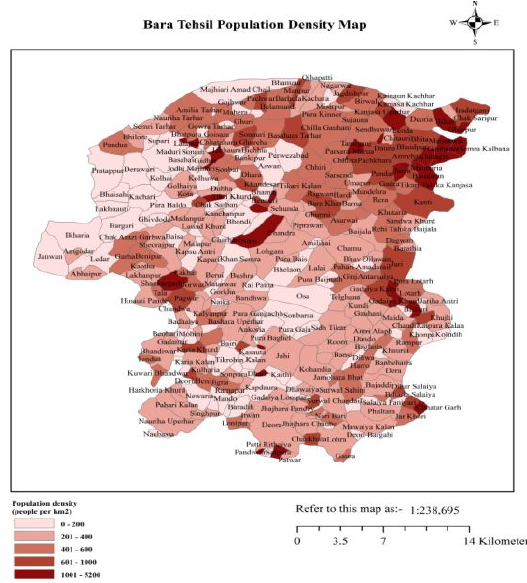
Figure 8. Bara tehsil school location map with road connectivity